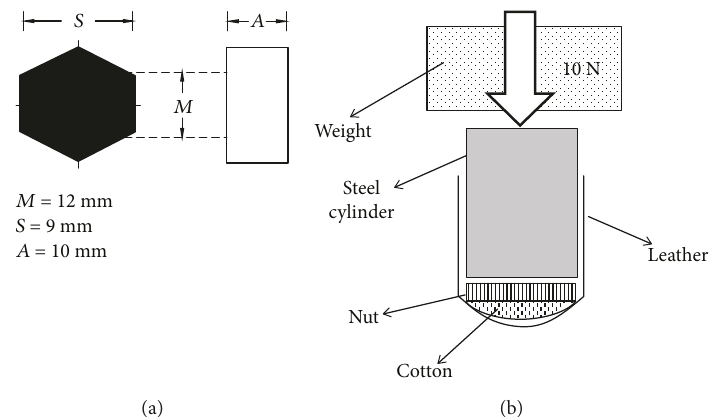
Figure 1: (a) View from the above and nut dimensions; (b) side view and stamp con fi guration.